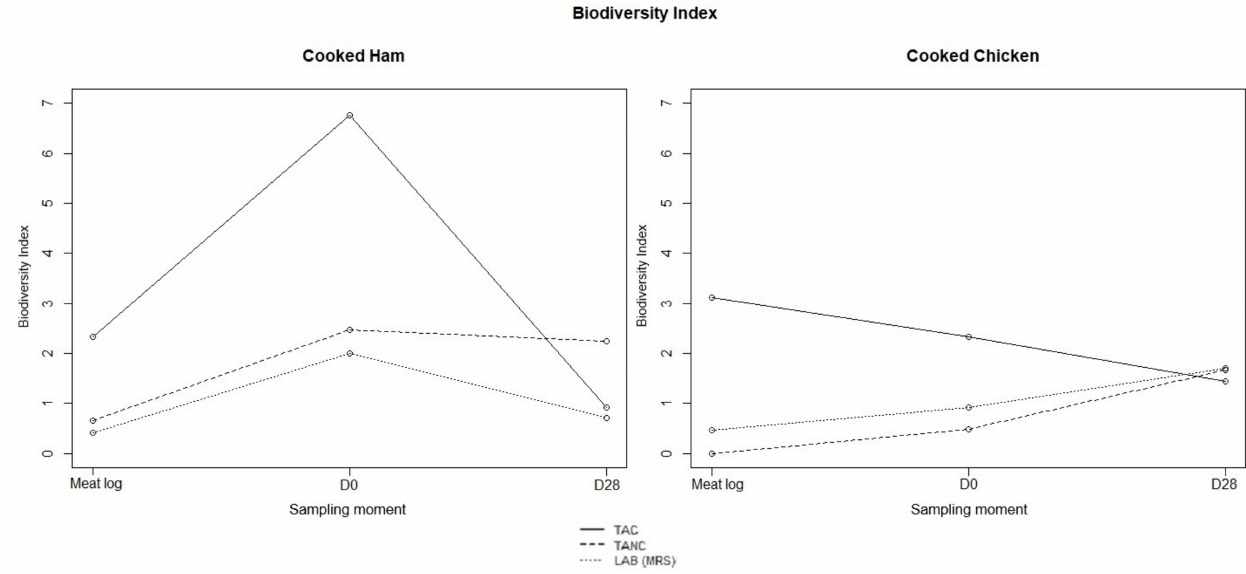
Figure 4. Biodiversity indexes for number of identified species found based on total psychrotolerant and psychrophilic aerobic (TAC) and anaerobic counts (TANC) and lactic acid bacteria counts (MRS agar) for cooked ham and cooked chicken at the different sampling